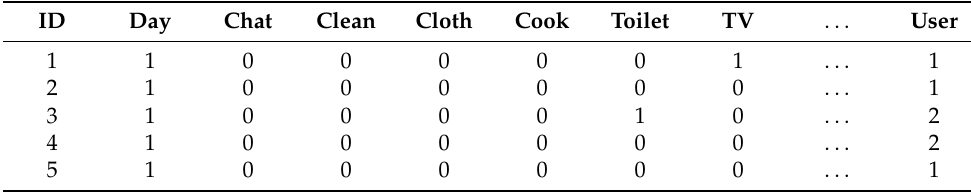
Table 7. Examples of multi-label activity data.